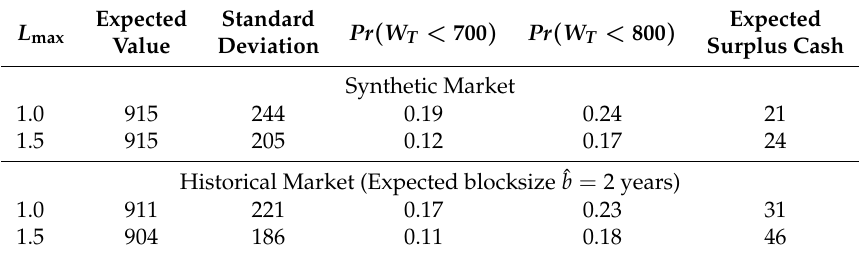
Figure 5. Cumulative distributions of normalized real terminal wealth for various salary escalation rates µ I for the QS optimal strategy. Input data provided in Tables 1 and 2, except as noted. Historical market results based on 10,000 bootstrap resampled paths using data from 1926:1 to 2015:12 with expected blocksize ˆ b = 2 years; surplus cash included. Table 7. Effect of varying maximum leverage indicator L max for the QS optimal strategy. Wealth units: thousands of dollars. Input data provided in Tables 1 and 2, except as noted. Synthetic market results computed using Monte Carlo simulations with 160,000 sample paths. Historical market results based on 10,000 bootstrap resampled paths using data from 1926:1 to